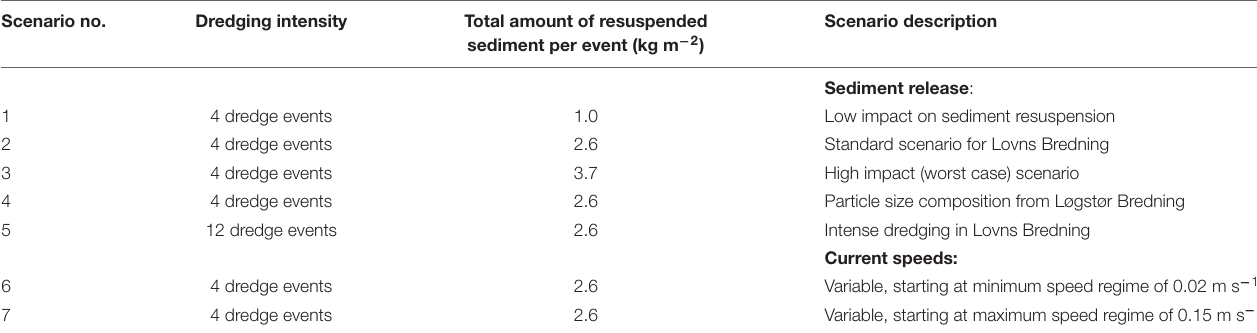
TABLE 3 | Model scenarios description of intensity, amount of sediment release, particle size composition and current speed. Scenario